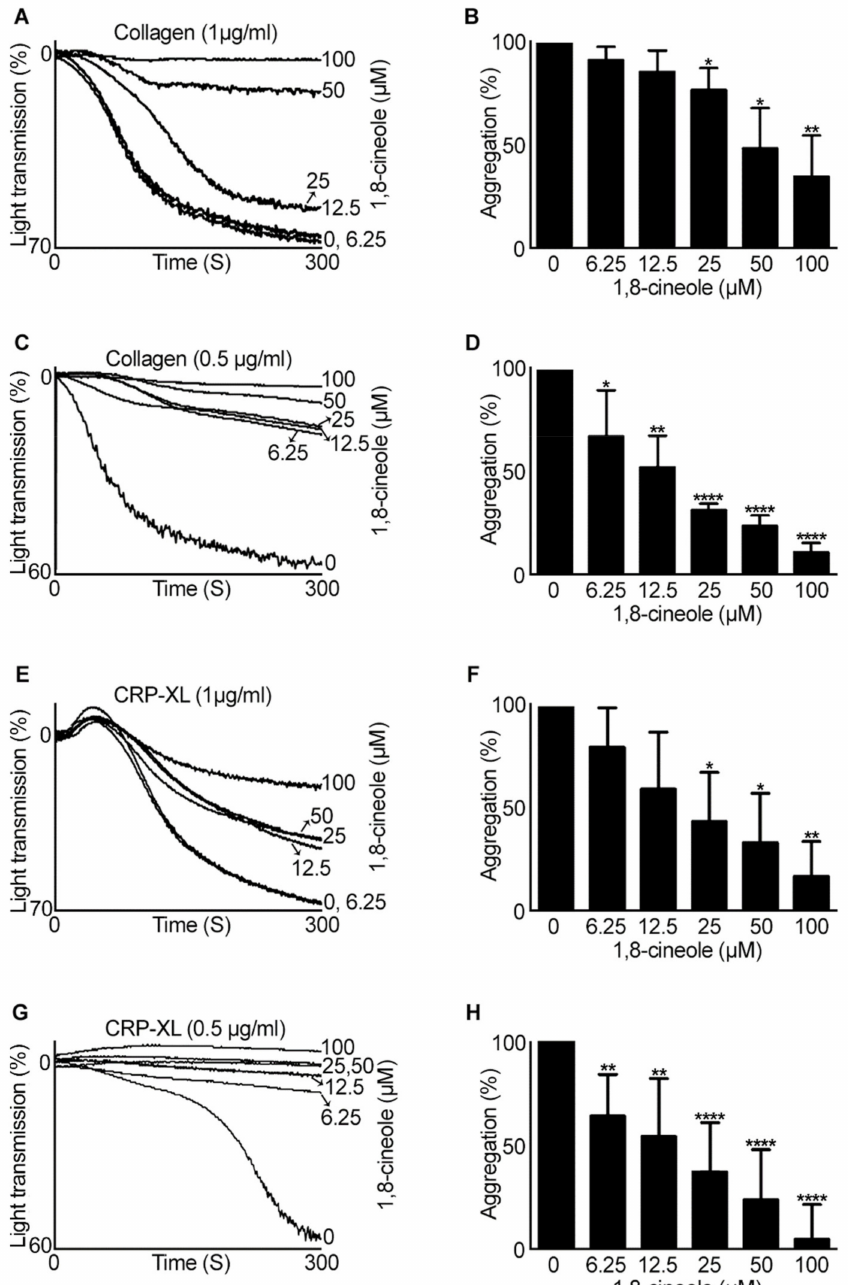
Figure 1. Effect of 1,8-cineole on GPVI agonists-stimulated aggregation in human isolated platelets. A vehicle control [0.1% ( v/v ) ethanol] or various concentrations of 1,8-cineole were incubated with human isolated platelets for 5 min prior to stimulation of aggregation with 1 µ g/mL ( A , B ) or 0.5 µ g/mL ( C , D ) collagen, and 1 µ g/mL ( E , F ) or 0.5 µ g/mL ( G , H ) CRP-XL. The level of aggregation was monitored for 5 min in an optical aggregometer. The aggregation traces shown are representative of five separate experiments. The percentage of aggregation for 1,8-cineole-treated samples was calculated by considering the level of aggregation obtained with the vehicle control (0) as 100%. Data represent mean ± SEM ( n = 5). The p values shown (* p < 0.05, ** p < 0.01, *** p < 0.001 and **** p < 0.0001) are as calculated by one-way ANOVA followed by Bonferroni post hoc